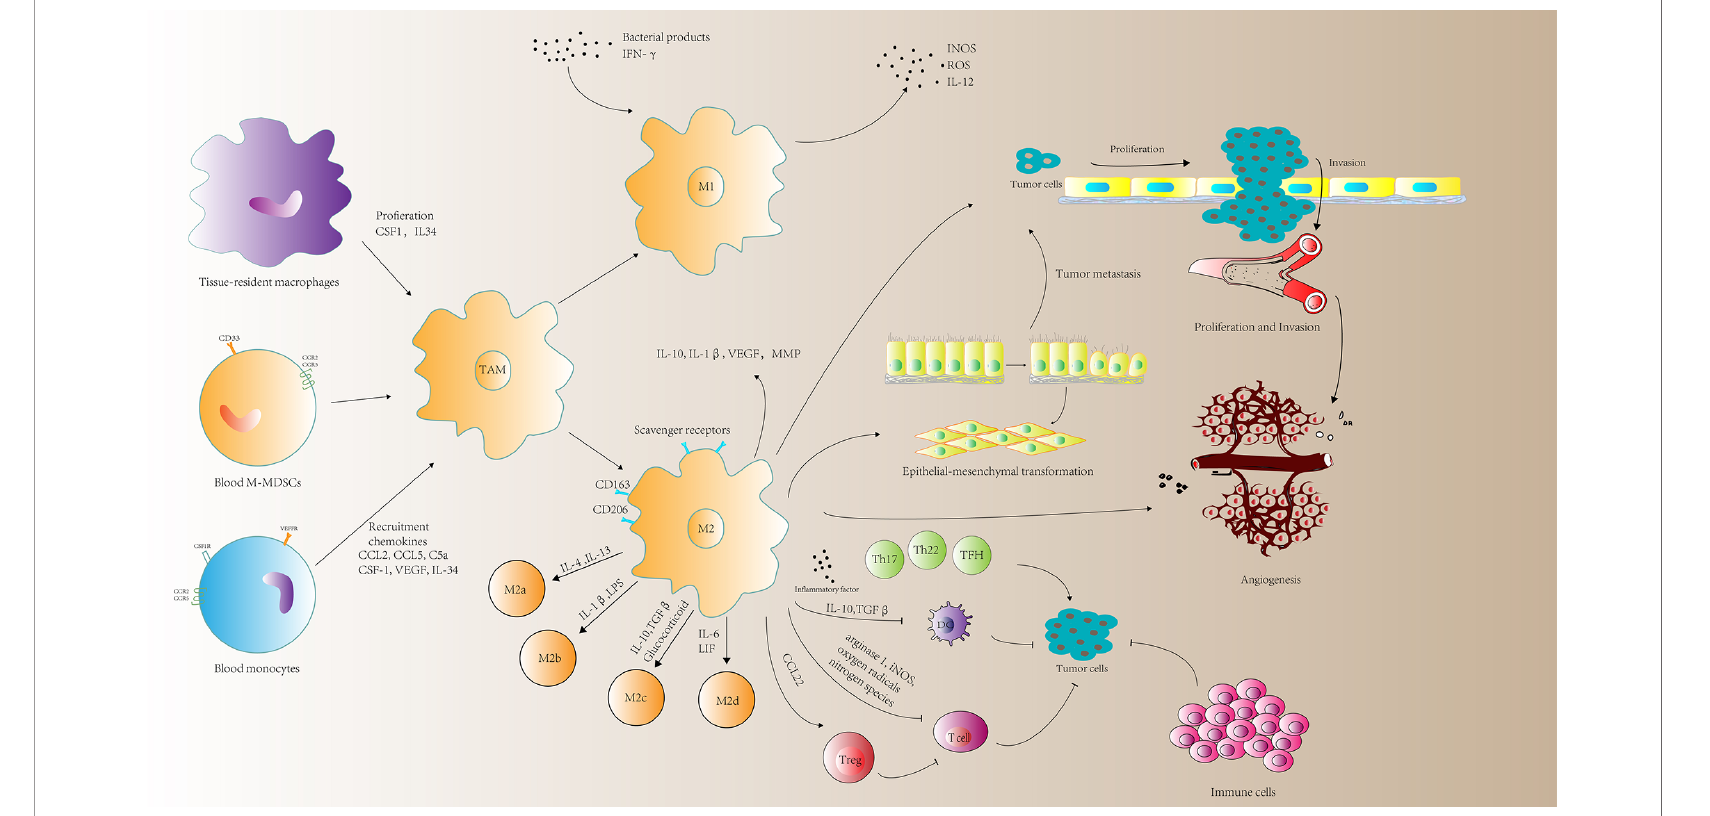
FIGURE 1 | A schematic representation of the roles of tumor-associated macrophages (TAMs) in tumor progression. TAMs can mediate immune response, tumor cell proliferation and invasion, angiogenesis and metastasis. MMP, matrix metalloprotein; M-MDSCs, monocyte-related myeloid-derived suppressor cells; CSF1, macrophage colony-stimulating factor; VEGF, vascular endothelial growth factor; ROS, reactive oxygen species; INOS, nitric oxide synthases; LIF, leukocytosis induced